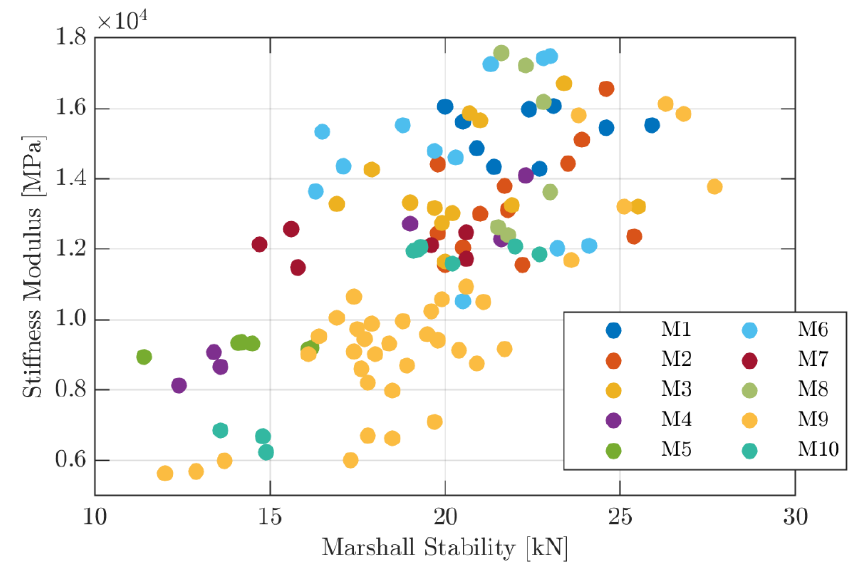
Figure 1. Scatter plot between Stiffness Modulus and Marshall Stability.